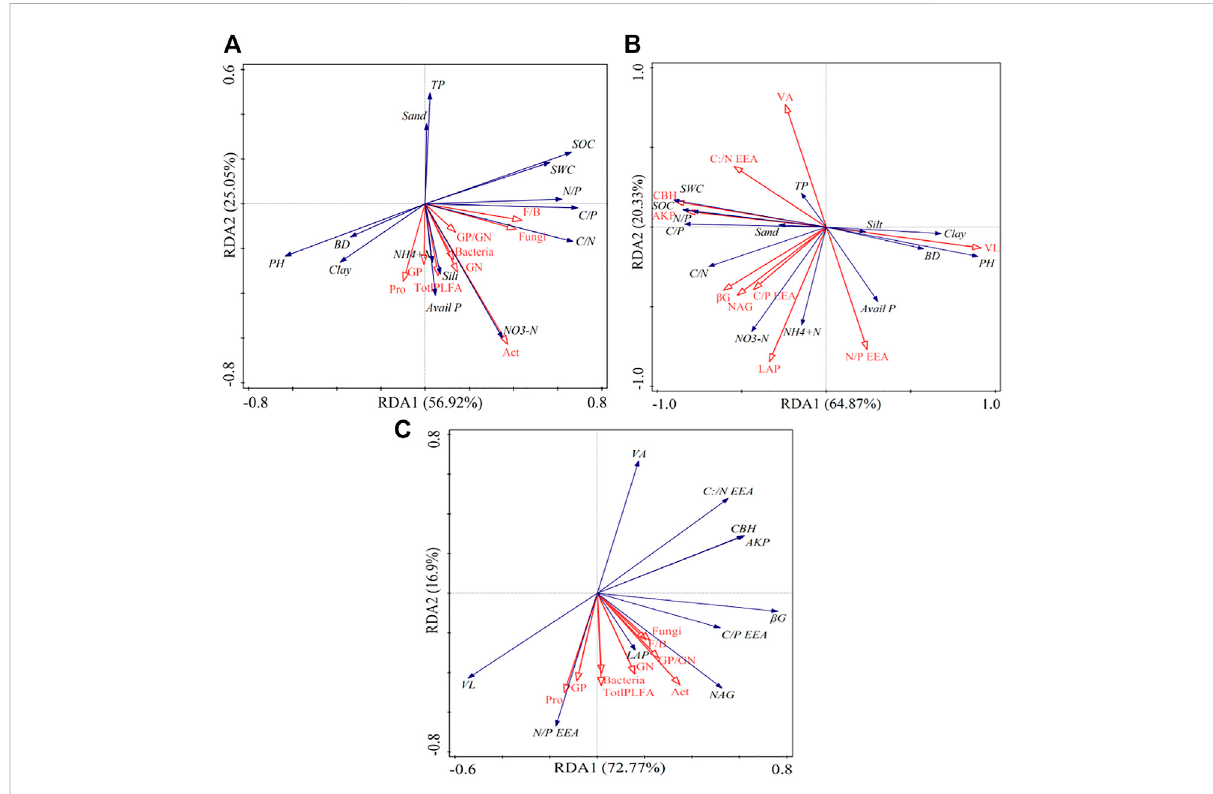
FIGURE 6 Redundancy analysis (RDA) showing the relationships between soil physicochemical properties and microbial components (A) , soil physicochemical properties and enzymatic variables (B) , soil physicochemical properties, soil microbial components, and enzymatic variables (C) . SWC: soil water content; BD: bulk density; SOC: soil organic carbon; TN: total nitrogen; TP: total phosphorus; AP: available phosphorus; NO 3 − -N: nitrate nitrogen; NH 4 + -N: ammonium nitrogen; C/N: the ratio of SOC to TN; C/P: the ratio of SOC to TP; N/P: the ratio of TN to TP.